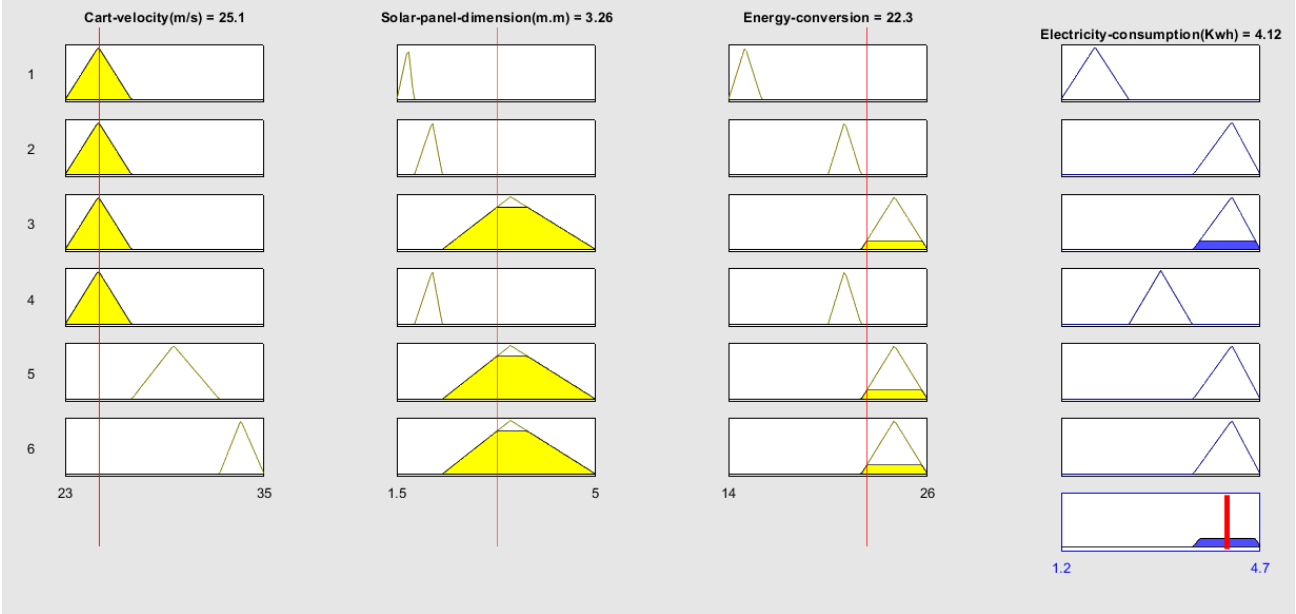
Figure 6. Results of electric power from the solar panel fuzzy logic system.